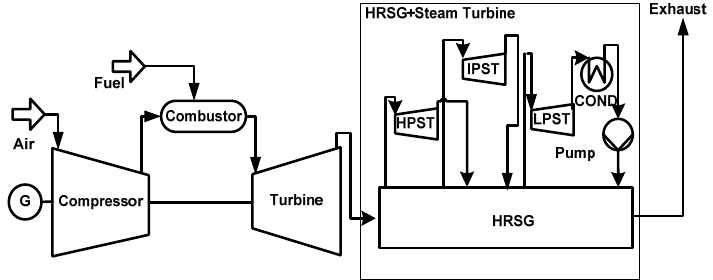
Figure 1. Configuration of case 1.